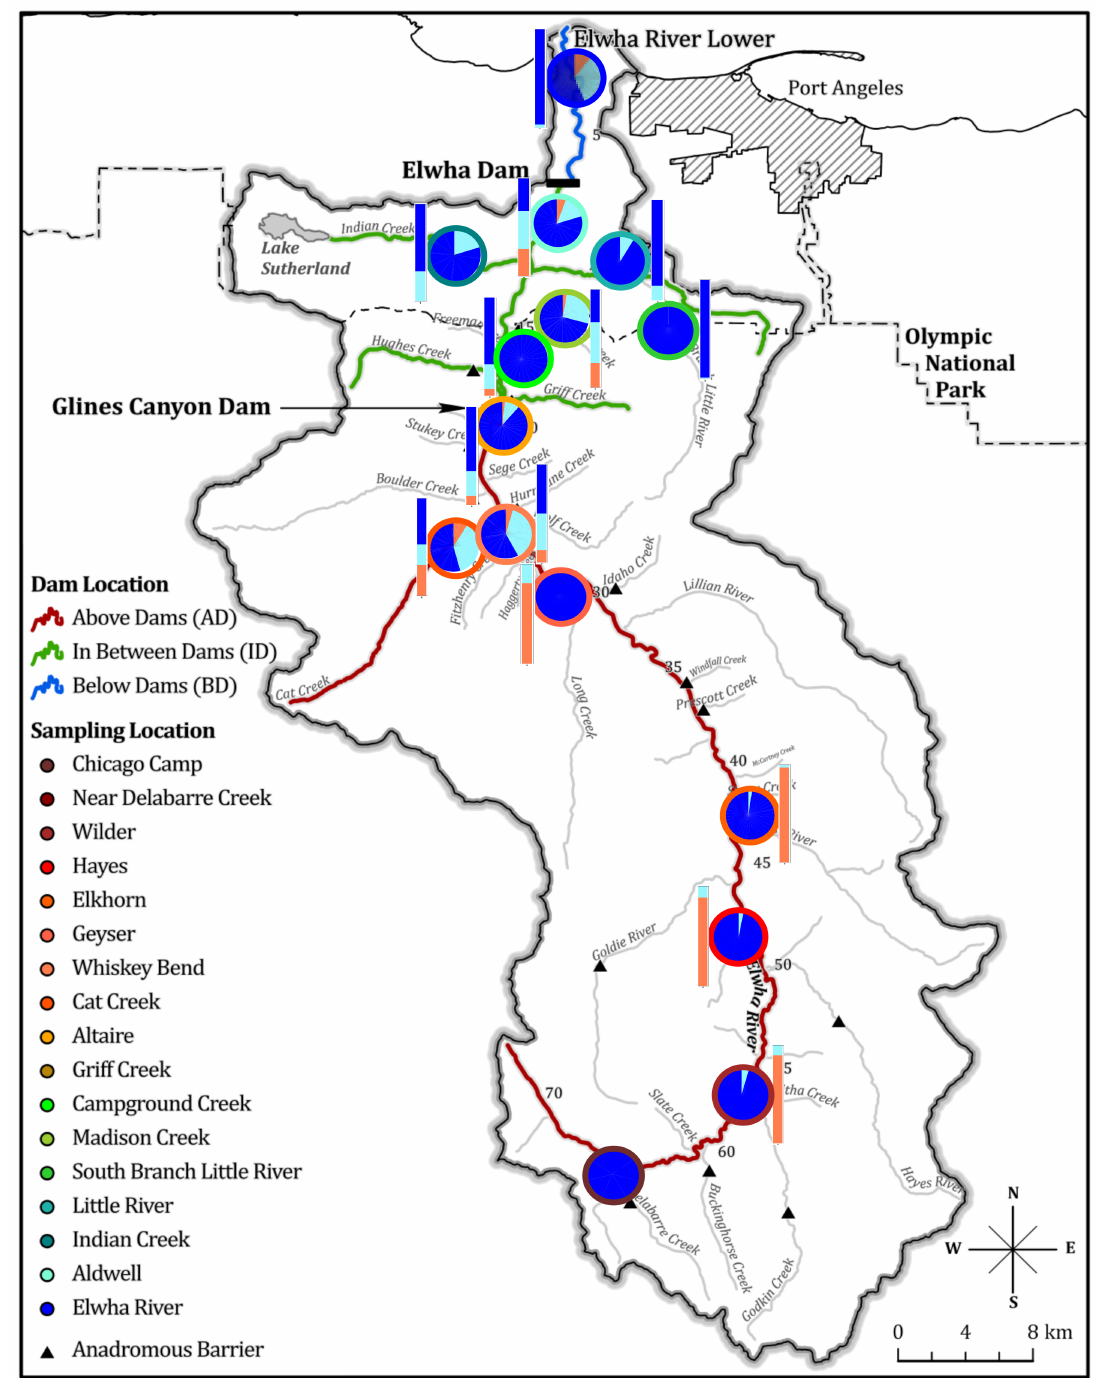
Figure 6. There was significant geographic variation in genotype frequencies for the Omy5 consensus locus (pie charts) and a candidate GREB1L variant (bar chart). The dark blue represents the resident homozygous genotype for the Omy5 consensus locus and the winter homozygous genotype for the GREB1L variant. The coral color represent the anadromous homozygous genotype for the Omy5 consensus locus and summer homozygous genotype for the GREB1L variant. The light blue represent the heterozygous genotypes. Chicago Camp did not have a sufficient number of individuals genotyped for the GREB1L variant to include a bar